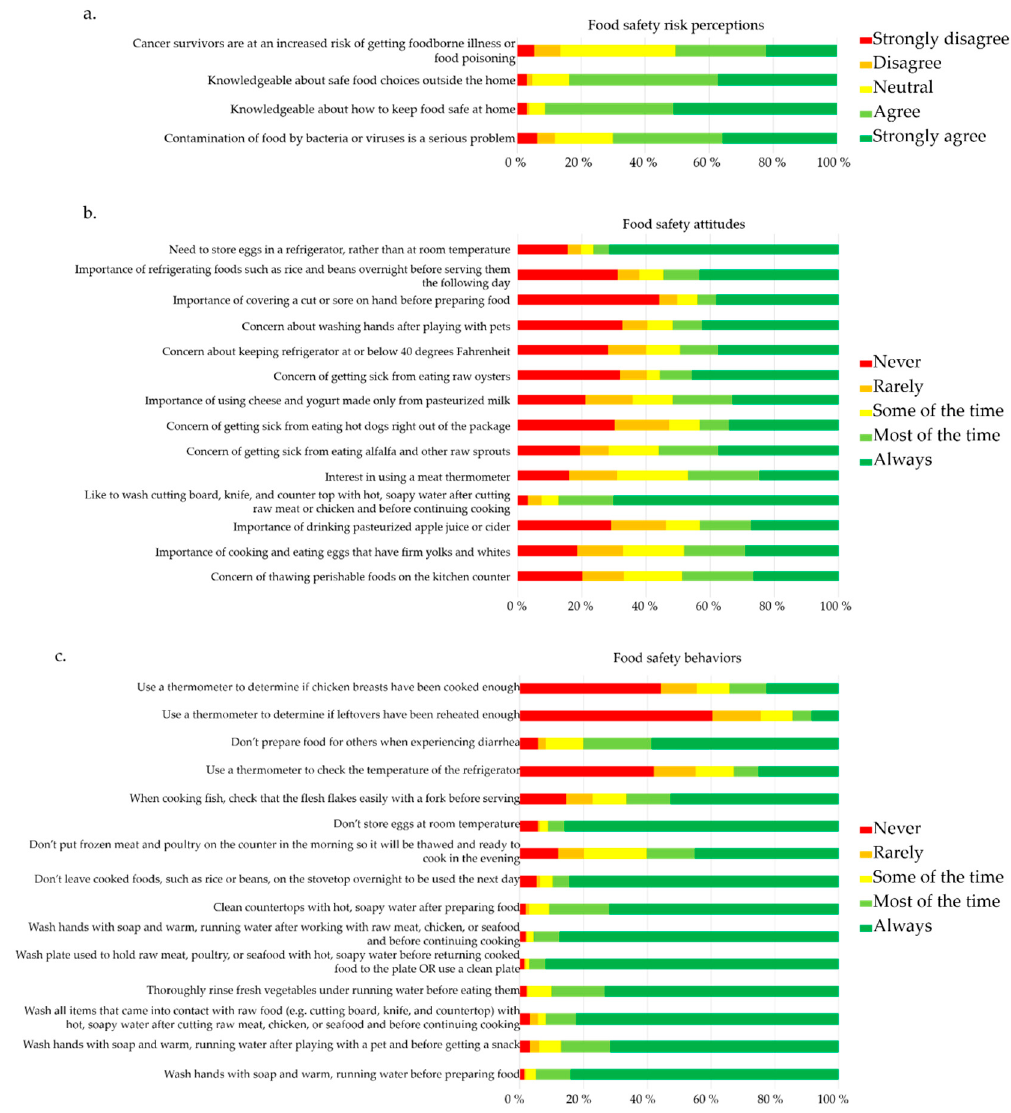
Figure 1. Percentile divisions of participant responses to ( a ) food safety risk perceptions, ( b ) food safety attitudes, and ( c ) food safety behaviors in the given survey.